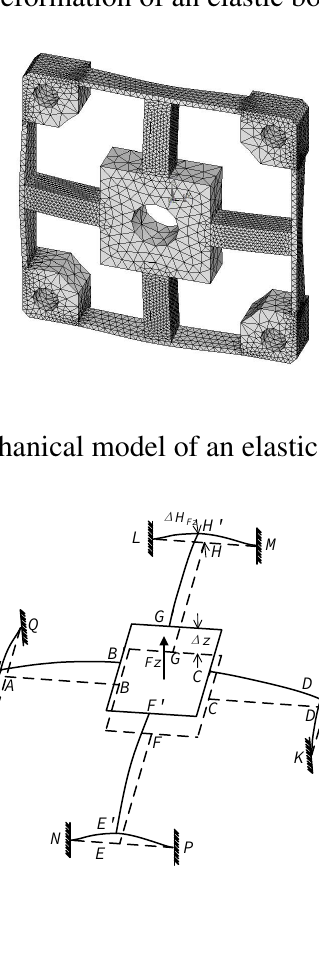
Figure 6. Deformation of an elastic body under F